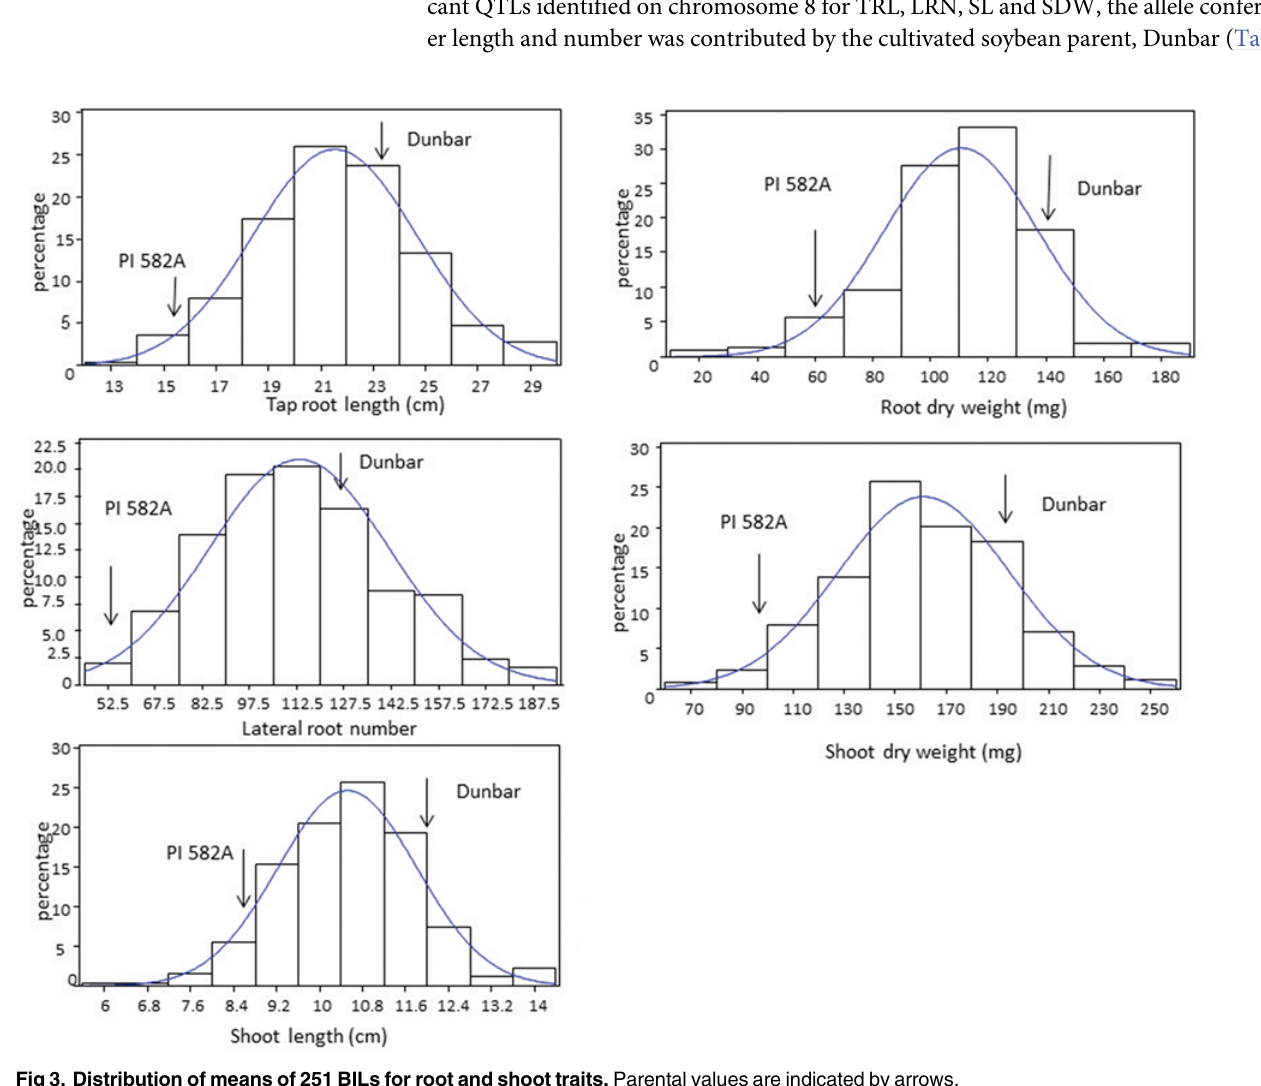
Fig 3. Distribution of means of 251 BILs for root and shoot traits. Parental values are indicated by